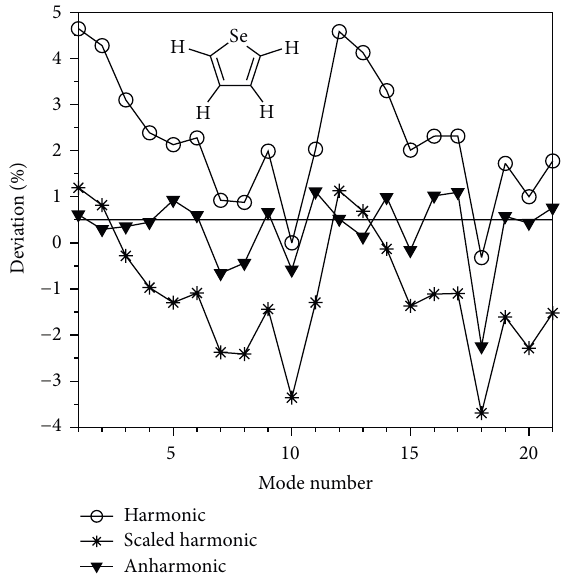
Figure 2: Percentage deviation relative to experiment [21] of the B3LYP/6-311G ∗∗ wavenumbers of C 4 H 4 Se.